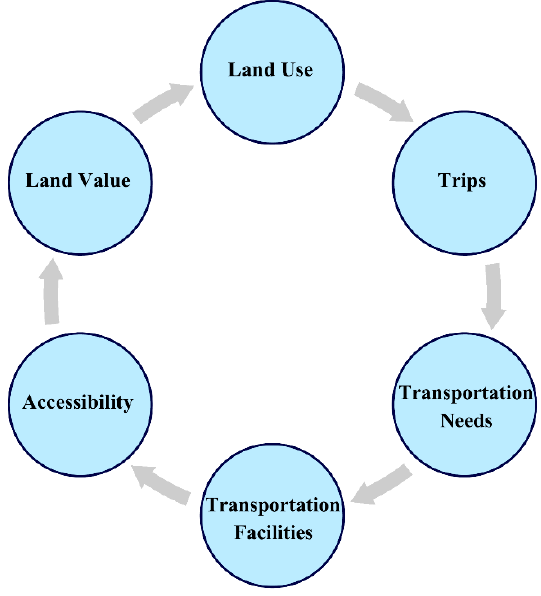
Figure 9. Land use and transport cycle (Source: [85]).